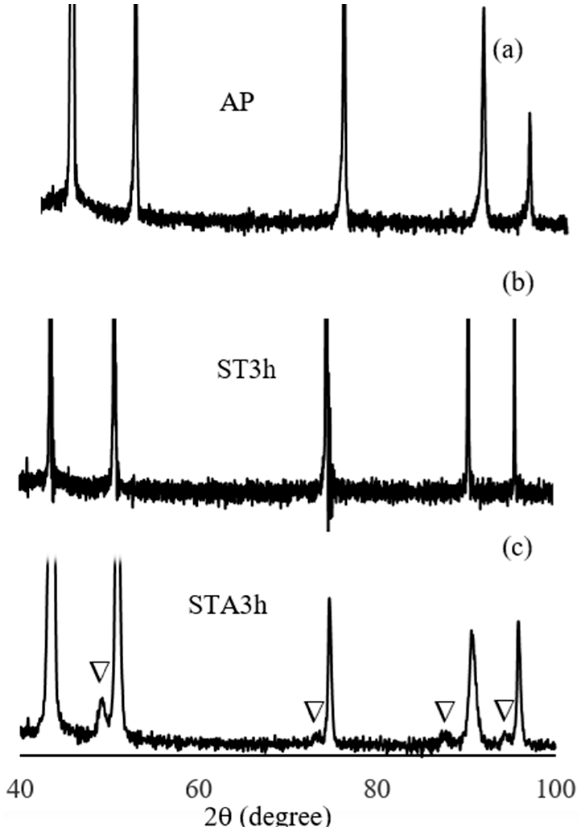
Figure 9. X-ray diffractograms of ( a ) AP, ( b ) ST3, and ( c ) STA3. The strong peaks are indexed to the fcc structure ( γ ), whereas the inverted triangles are pointing to the peaks indexed to the tetragonal structure ( γ (cid:48)(cid:48) phase).